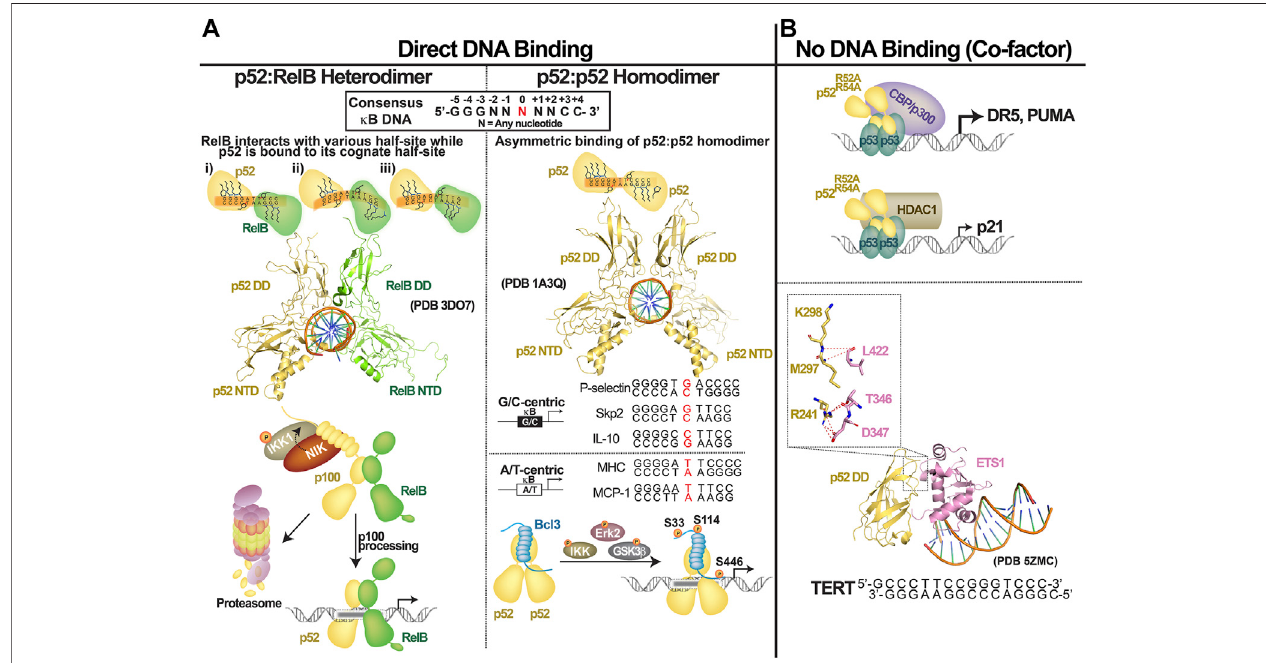
FIGURE 4 | Transcriptional regulation by NF- κ B2/p52. p52 regulates gene expression by: (A) direct binding to the consensus κ B DNAs as (left) p52:RelB heterodimer or (right) p52:p52 homodimer which functions together with Bcl3; (B) p52 could also function as co-factor by interacting with other transcription factors such as p52 and